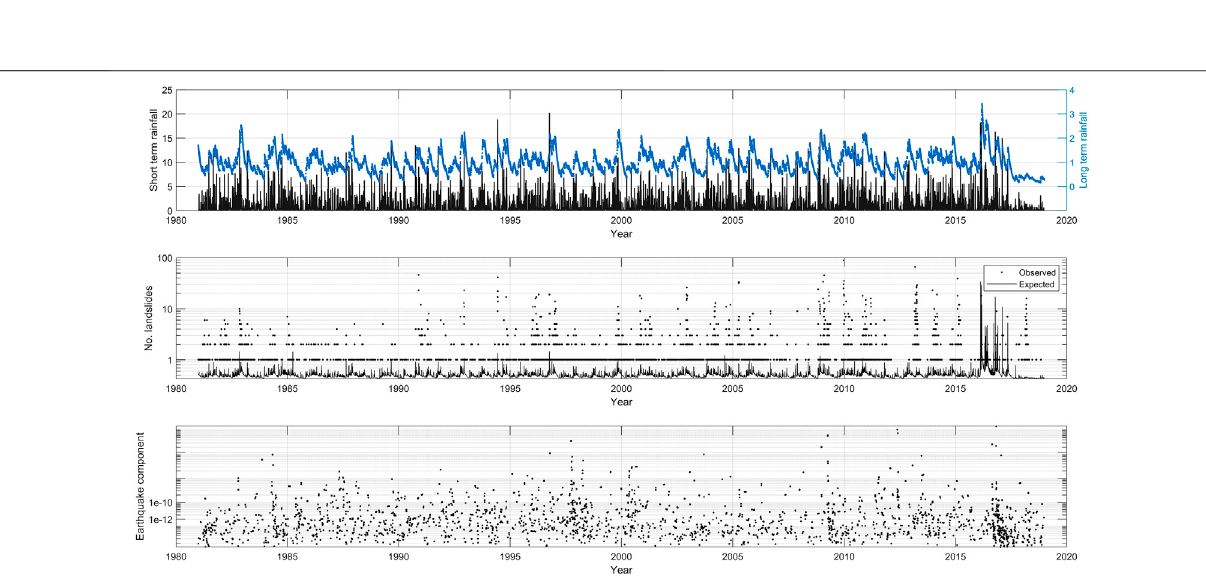
Frontiers in Earth Science |